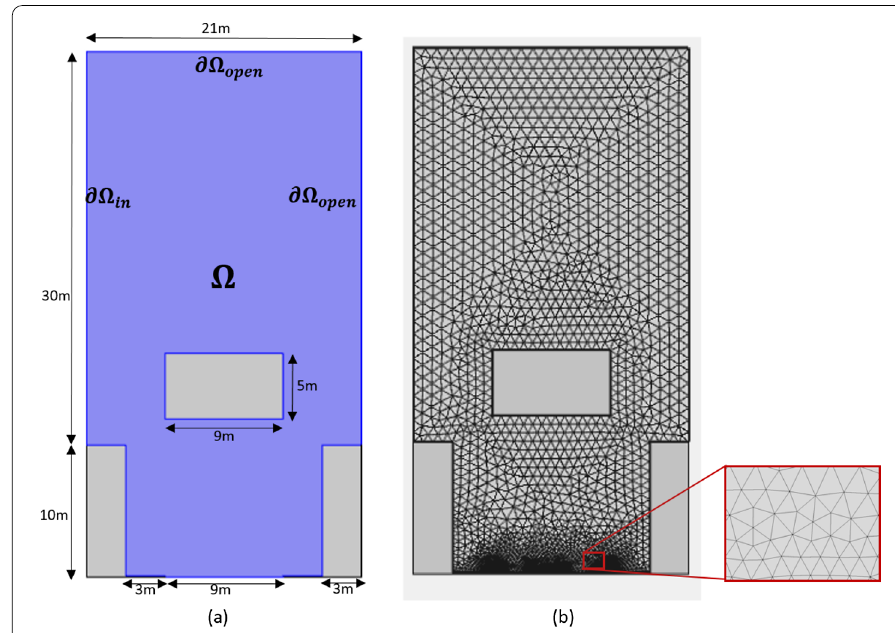
Figure 1 Geometric domain of the two dimensional of the street canyon: ( a ) defining the domain area, and ( b ) meshing the computational domain